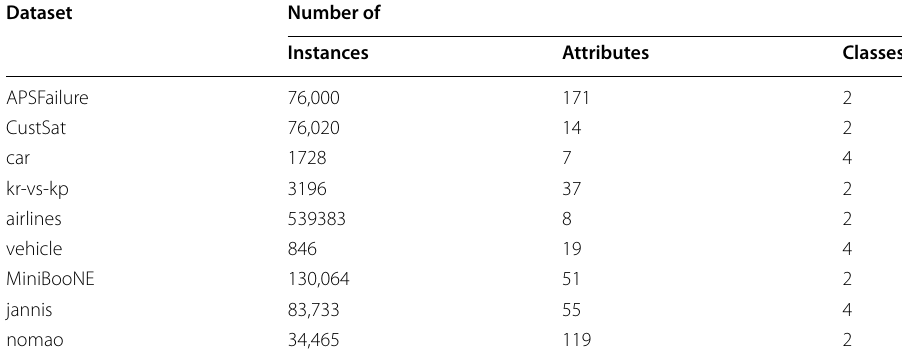
The best ones are highlighted in bold